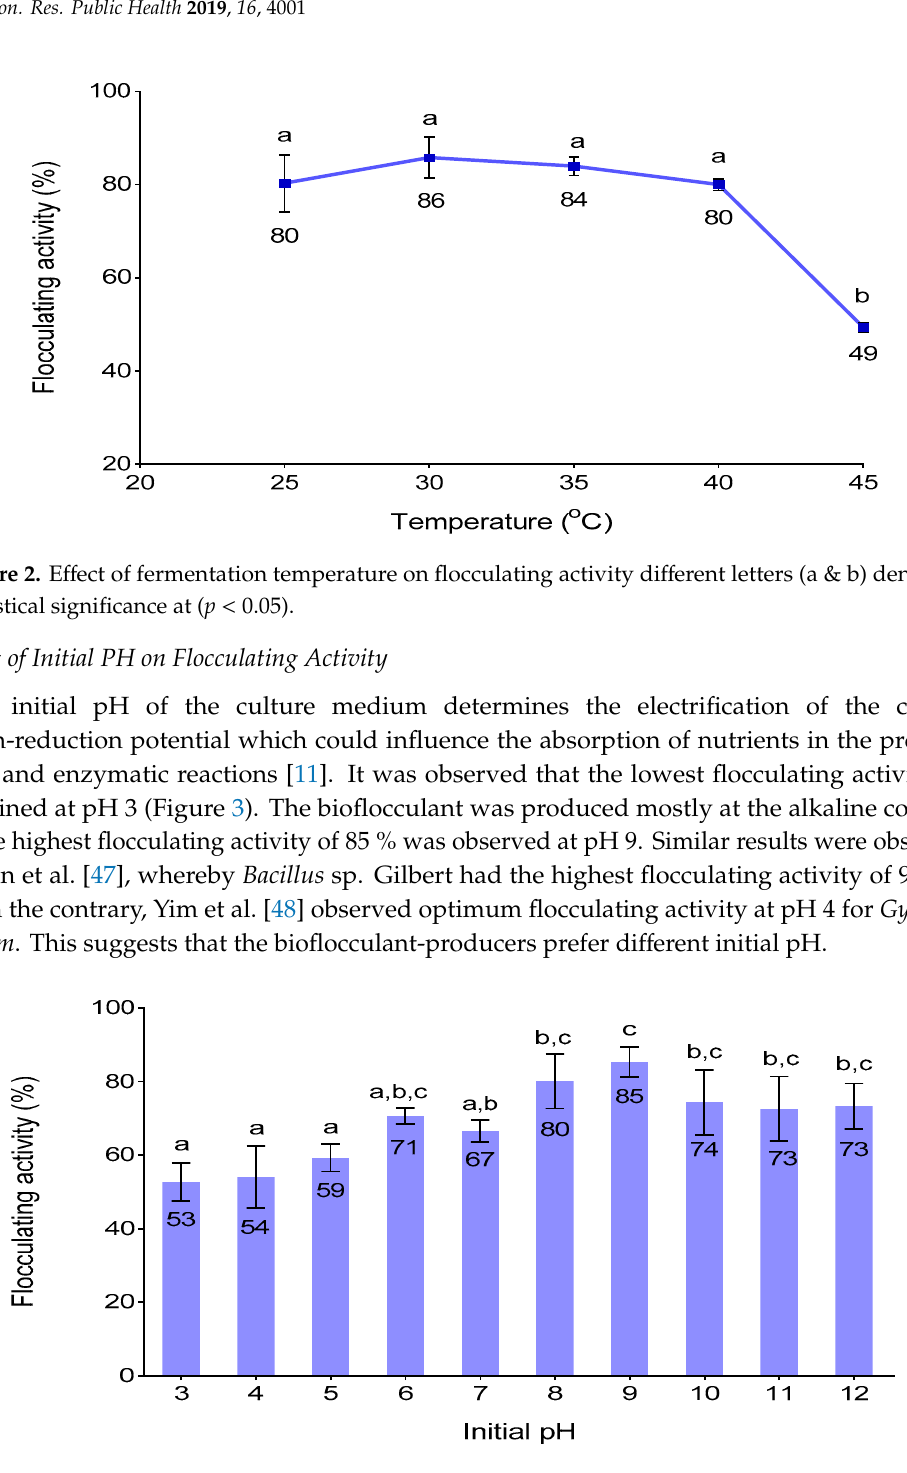
Figure 3. E ff ect of initial pH on flocculating activity di ff erent letters (a, b & c) denotes statistical Figure 3. Effect of initial pH on flocculating activity d ifferent letters (a, b & c) denotes statistical significance at ( p < significance at ( p < 0.05).